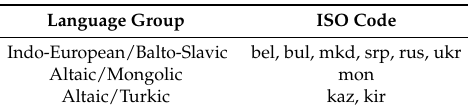
Table 4. Cyrillic script dataset.